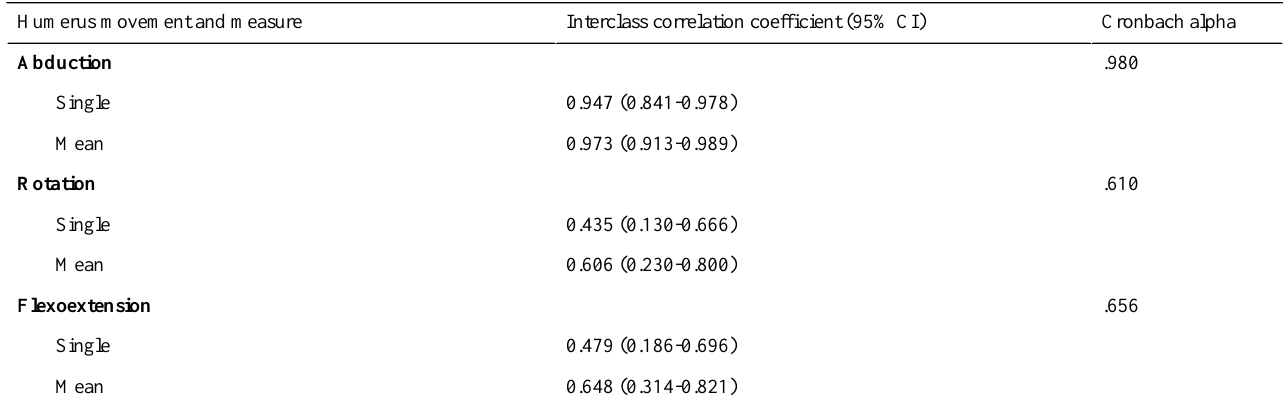
Table 3. Interclass correlation coefficient interdevices for abduction movement.